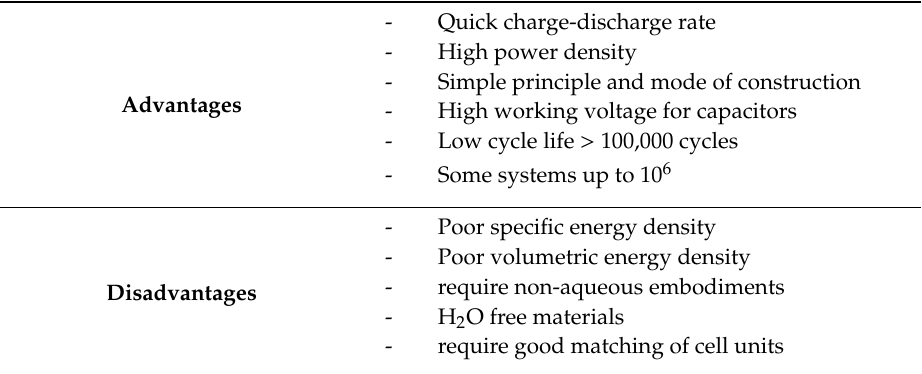
Figure 4. A schematic of a dielectric capacitor. Table 2. Advantages and disadvantages of electrical energy and capacitor designed in MEHV.